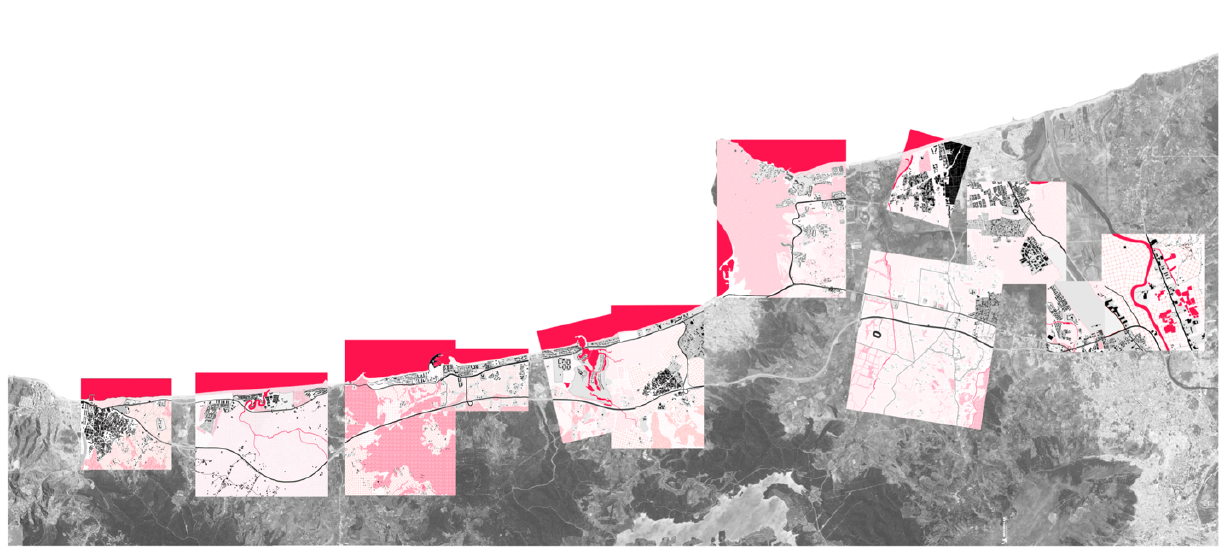
Figure 2. Grand Tetouan region: Synthetic map of the urban materials. Note: The graphic expression of the overall cartogra- phy was based on the one developed by Cesare Macchi Cassia’s team in the study they realized on Milan in the late 1990s (Macchi Cassia, 1998). Source: Terrains d’Architecture, Master in Architecture Design Studio